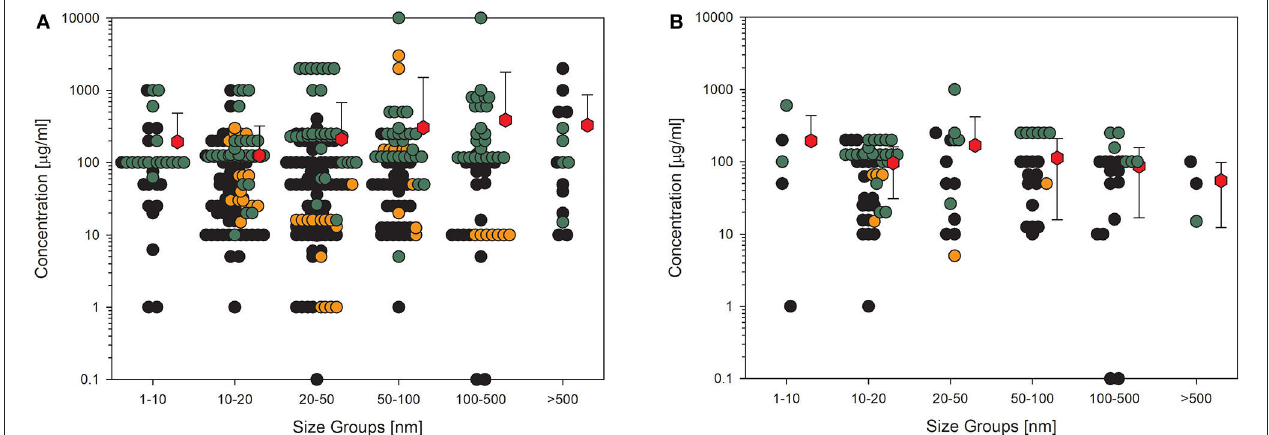
FIGURE 2 | Results of the evaluation of in vitro studies on induction of cell death in cells treated with amorphous silica. Data have been collected in six size groups for primary particle size as indicated on the abscissa. (A) All available datasets; (B) datasets from studies with high-quality scores of 0.8 or 1. Shown are the concentrations given in the publications for the no-observed-effect concentration (EC 0 ): black circles ( ) or the lowest-observed-effect concentration (LOEC; if no EC 0 was available): orange circles ( ) the upper-no-observed-effect concentration (UNOEC; if the highest tested concentration could not induce the investigated effect): green circles ( ). The red hexagons ( ) indicate the mean of all data for one size group ± SD. Data points taken from the references are given in the Supplementary Material .